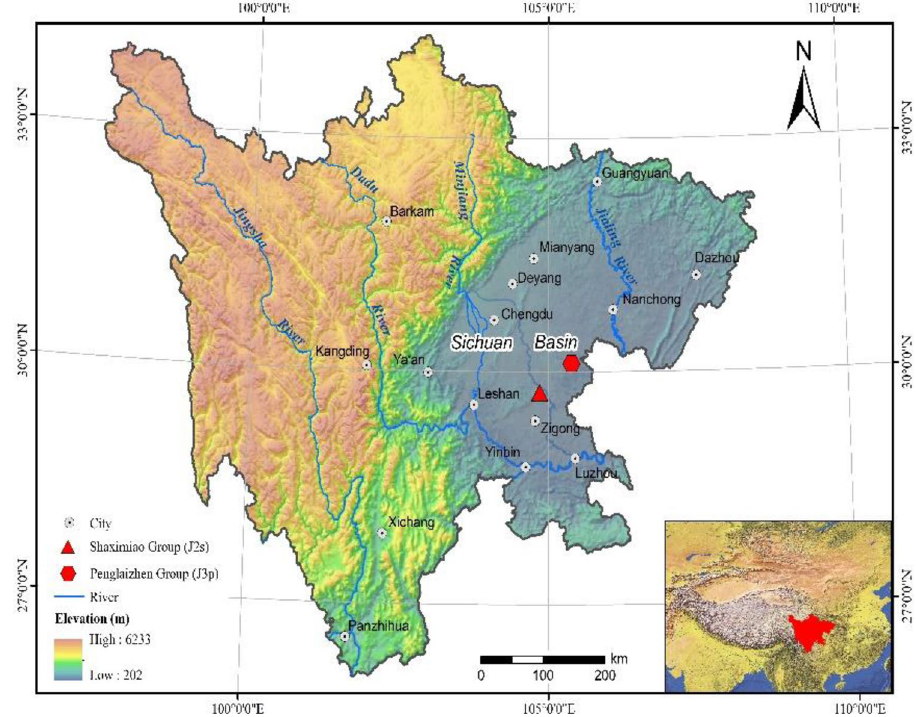
Figure 1. Location of the sampling sites. The map created by QGIS3.16, https:// www. qgis. org/ en/